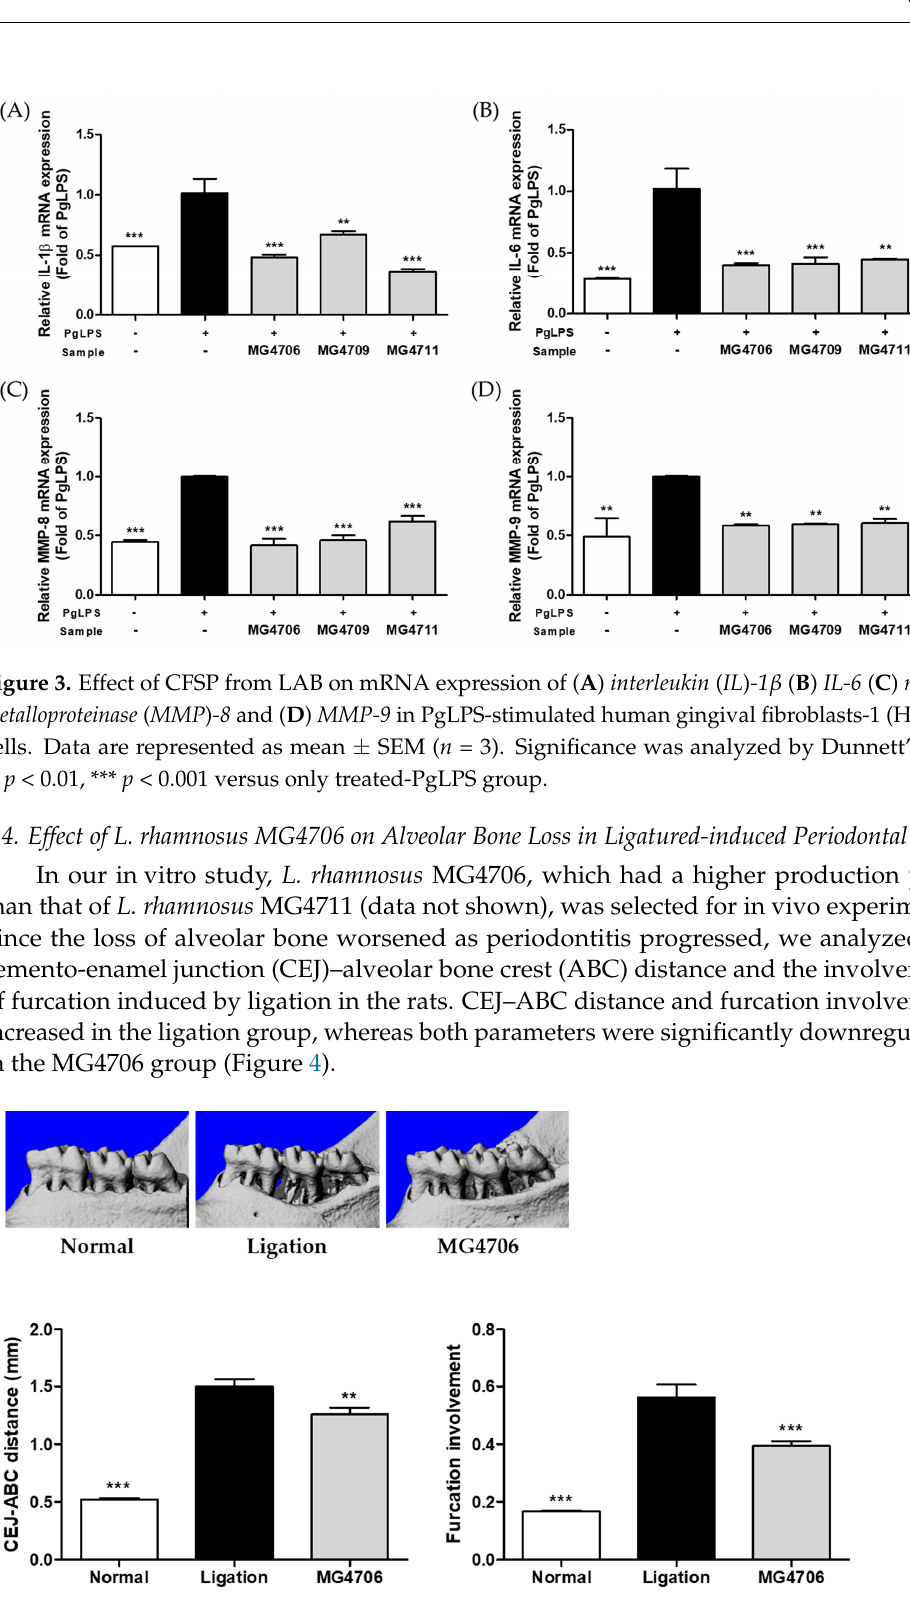
Figure 4. Effect of MG4706 on alveolar bone loss in ligature-induced periodontal rats. The ce- mentoenamel junction–alveolar bone crest (CEJ-ABC) distance and furcation involvement were used as indices of alveolar bone loss and were measured through micro-CT imaging. Data are represented as mean ± SEM ( n = 8). Significance was analyzed using Dunnett’s test. ** p < 0.01, *** p < 0.001 versus ligation group.